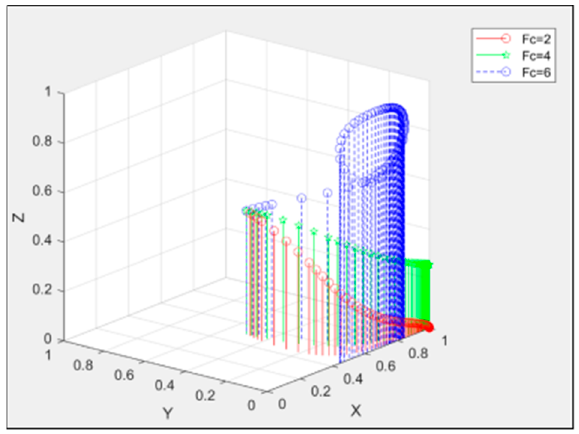
Figure 8. The Influence of punishment FC on strategy choice of each party.